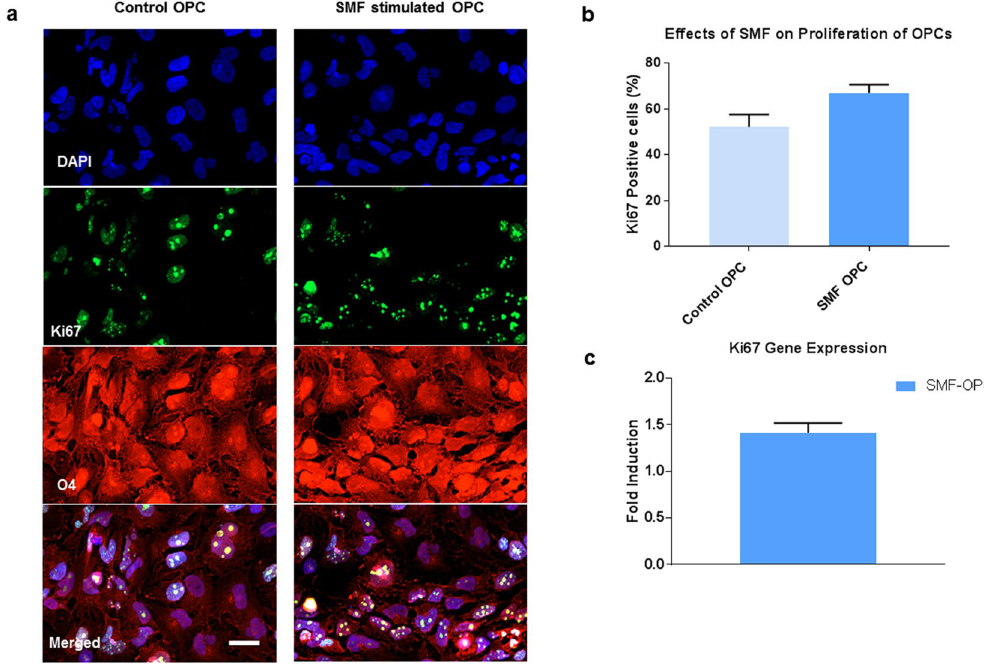
Figure 4. Effects of SMF on OPC proliferation. ( a ) Representative images of OPC stained with O4 and Ki67 markers, ( b ) Quantification of Ki67 positive cells in SMF stimulated OPCs and control, ( c ) mRNA expression level of proliferative marker Ki67 in SMF stimulated OPCs as compared to control OPCs. Data represented as mean ± SEM. Scale bar = 20 µ m.